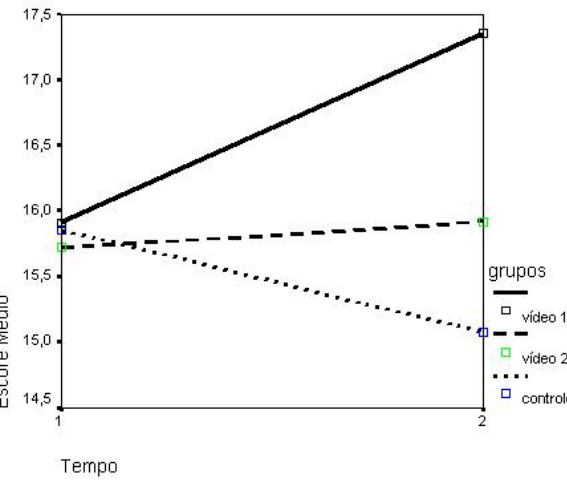
Figura 3. Interação do escore médio do TCCHA (tempo 1 e tempo 2) nos grupos (1, 2 e controle) ( N